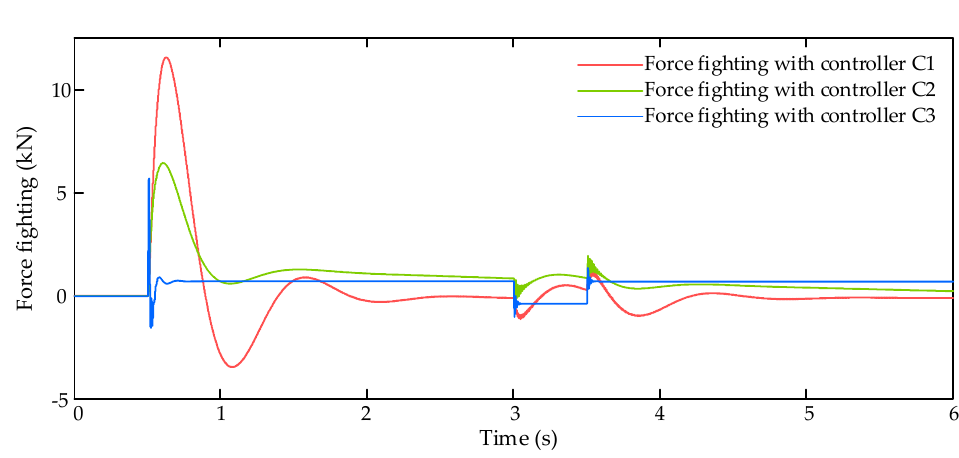
Figure 5. Force fighting results with step signal input command.